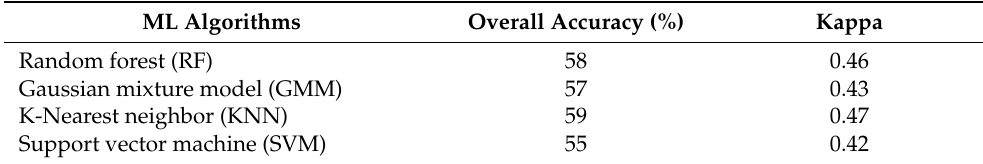
Table 4. Overall accuracy (%) and kappa coefficient values of four different machine learning (ML) algorithms used to classify Sentinel-2 satellite